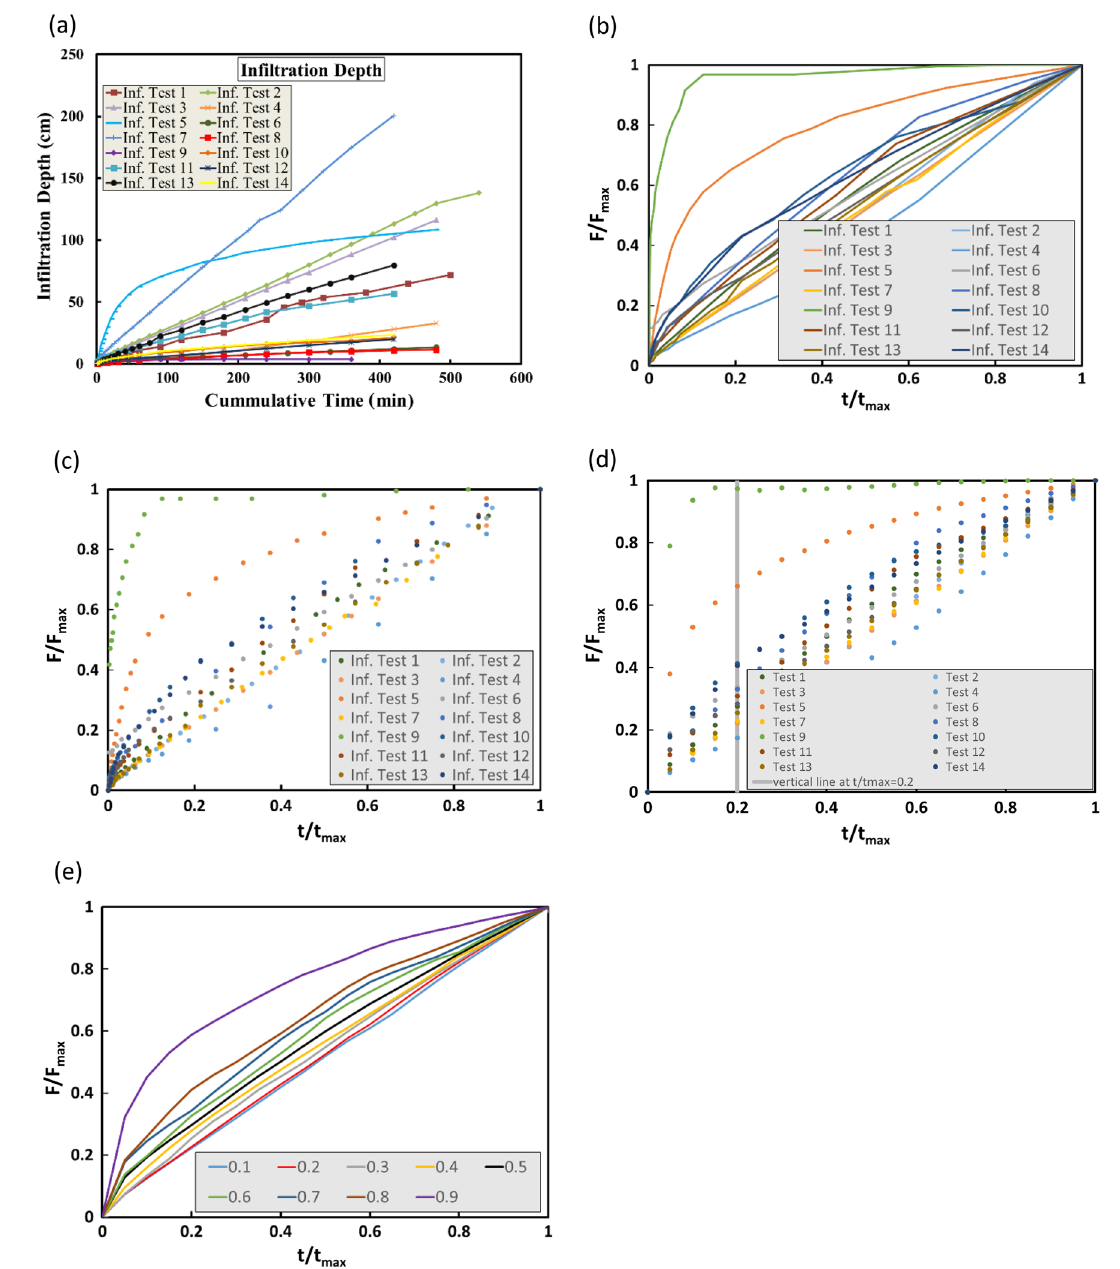
Fig. 7 Transformation of the infiltration tests into dimensionless and estimation of the percentiles. a Actual infiltration tests, b transferring the absolute values ( F , and t ) into dimensionless values ( F / F max ) and ( t / t max ), c presenting the dimensionless values into dots, d interpolat- ing the dimensionless ( F / F max ) at equal intervals of dimensionless